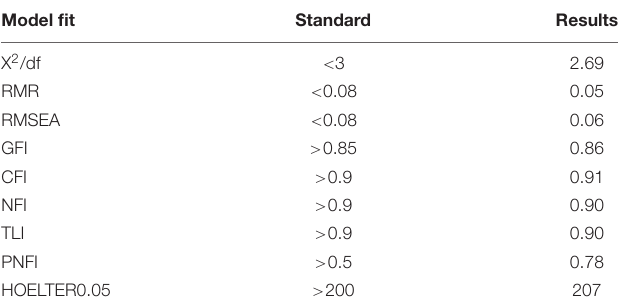
TABLE 5 | Fit of the structural model.